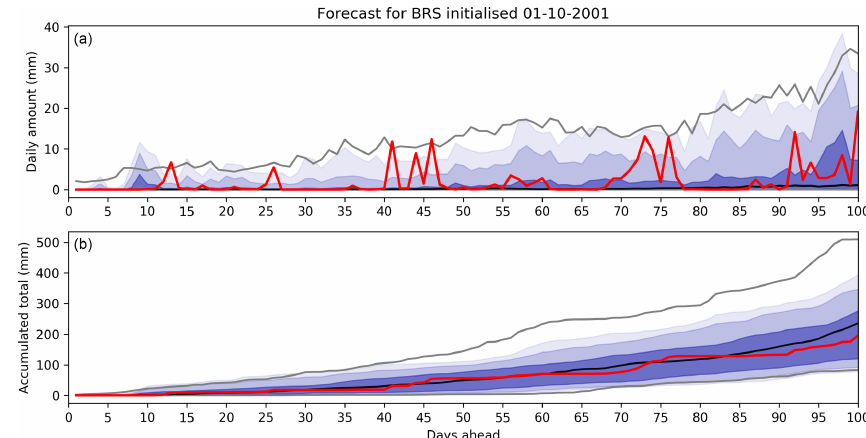
Figure 2. Example RPP-S rainfall forecast for the Burdekin River at Sellheim, initialised on the 1 October 2001 and forecasting 100 days ahead. Forecasts of daily amounts are shown in (a) and forecasts of accumulated totals are shown in (b) . Dark blue is the forecast [0.25, 0.75] quantile range; medium blue is the forecast [0.10, 0.90] quantile range; and light blue is the forecast [0.05, 0.95] quantile range. Grey lines are the climatological reference forecast [0.05, 0.95] quantile range. The black line is the climatological reference forecast median. The red line is the